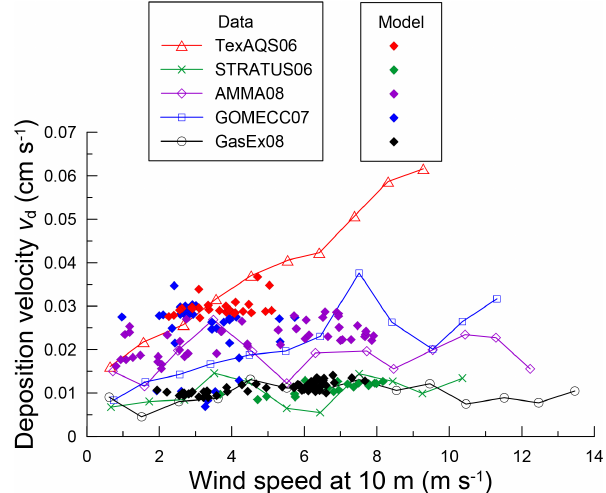
Figure 6. Ozone dry deposition velocity ( v d ) as a function of sea surface temperature (SST) from five field experiments (Helmig et al., 2012; L. Bariteau, personal communication, 2016) and the cor- responding values obtained from the ACCESS-UKCA model using the two-layer reactivity scheme for ozone deposition to the ocean.